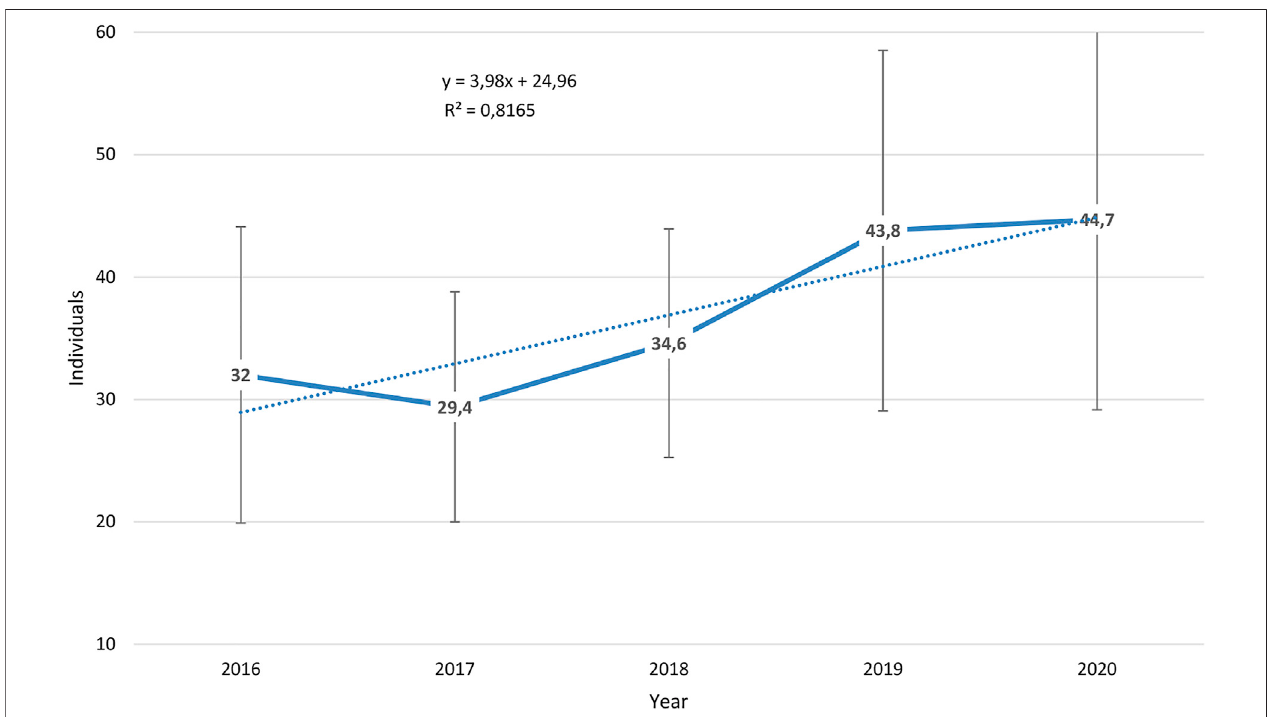
FIGURE 5 | Correlation between all individuals any years, standard deviation, slope, linear regression slope (dotted), and equation ( n = 50).